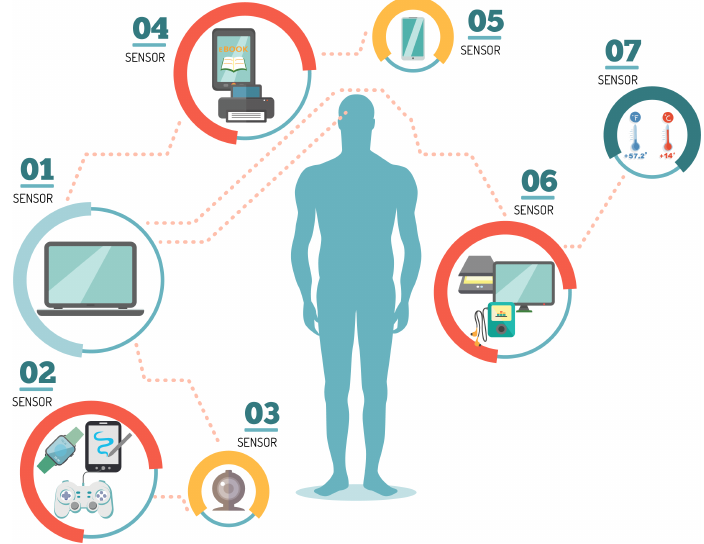
Figure 1. Types of body sensors for human wireless